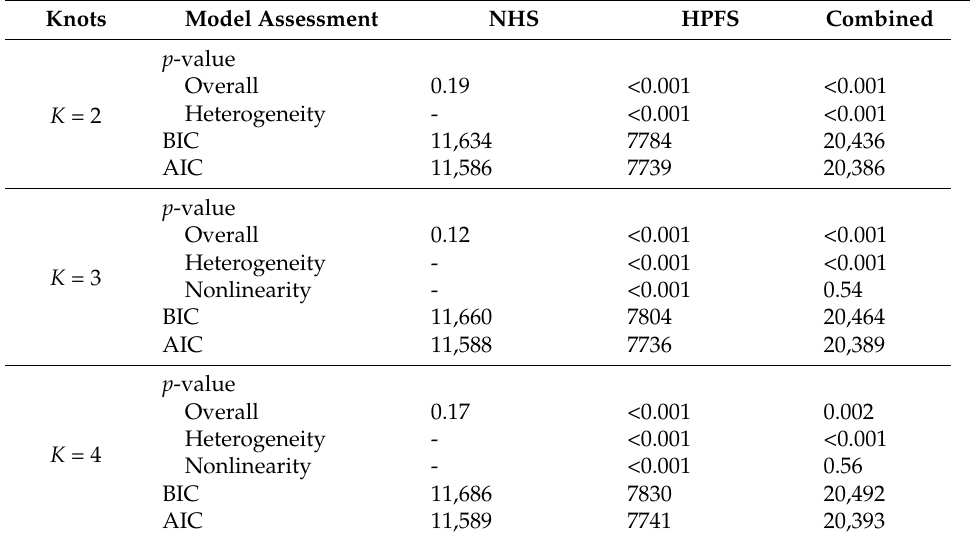
Table 1. Model testing for the association of categorical alcohol intake (>15 g/day vs. 0 g/day) with colorectal cancer incidence, based on the main model for three functional forms and three cohorts. Knots Model